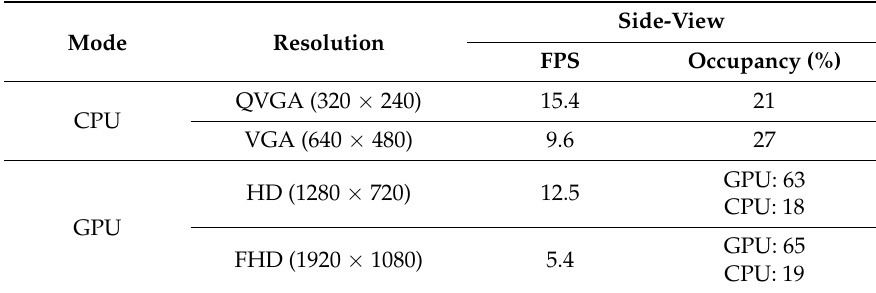
Table 4. FPS and resource occupancy per resolution of the proposed